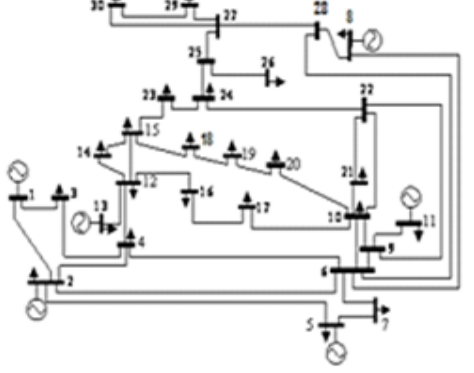
Figure 4. IEEE 30 bus test case